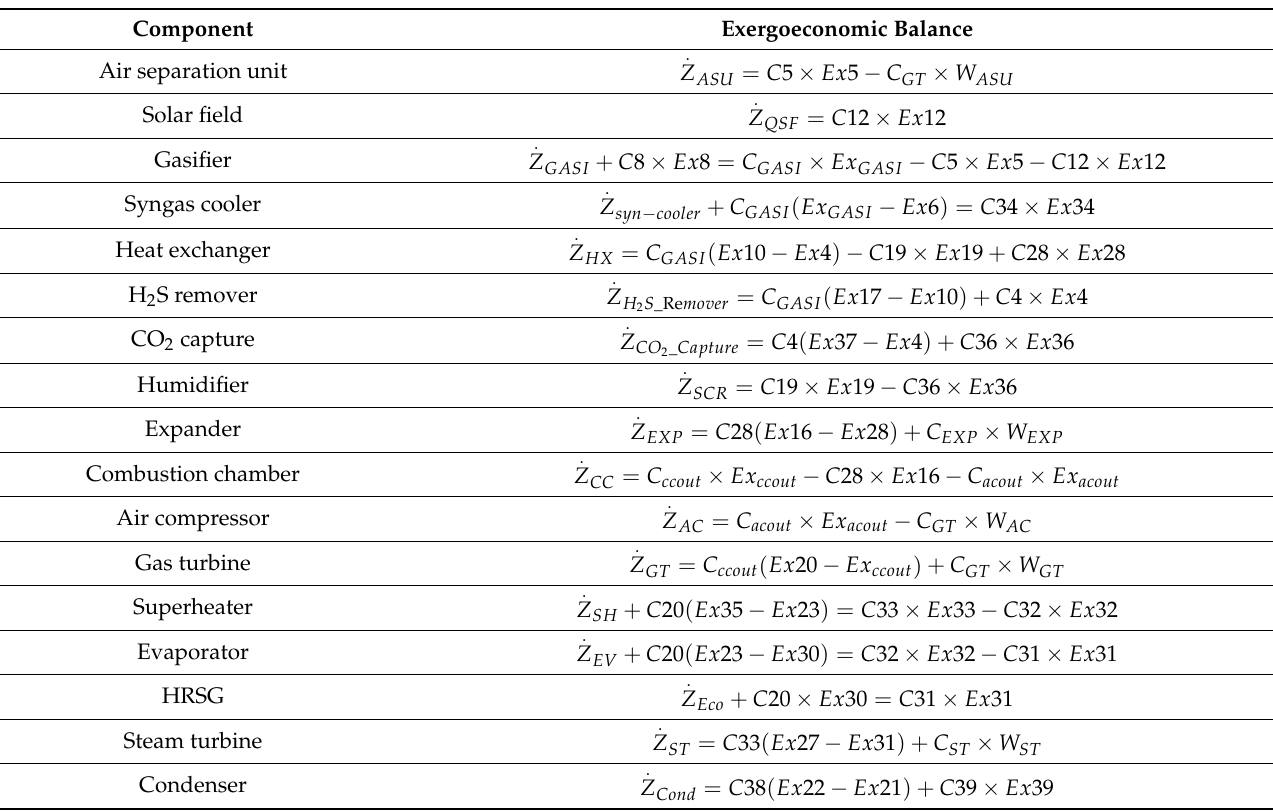
Table A4. Exergoeconomic formulation for the different ISGC system components [17].